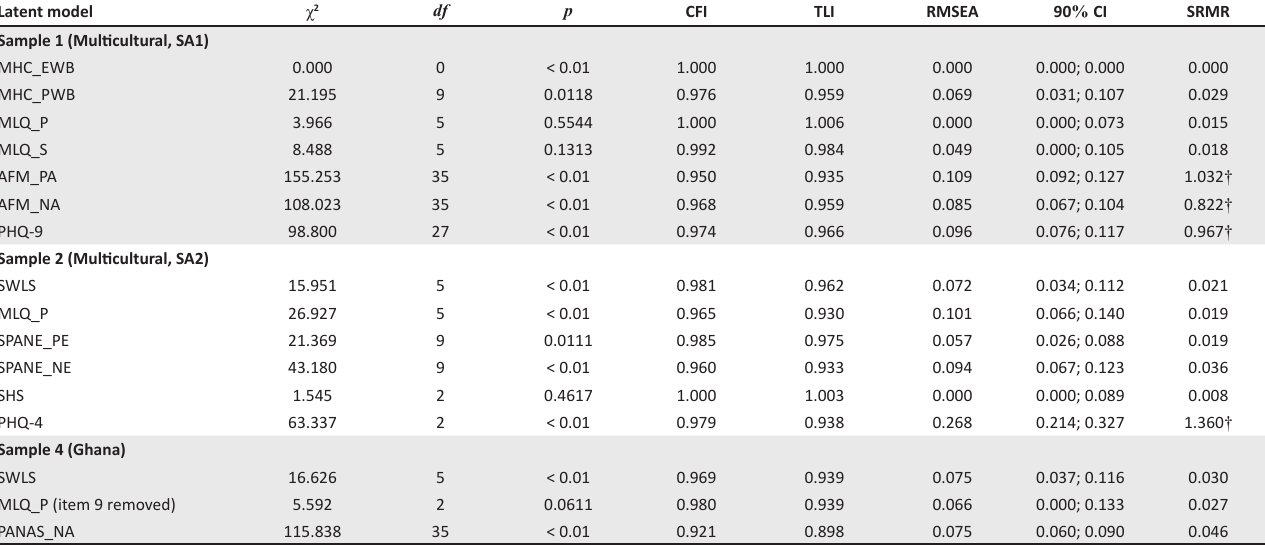
TABLE 4: Global fit indices for the criterion-scales used in the various samples. Latent